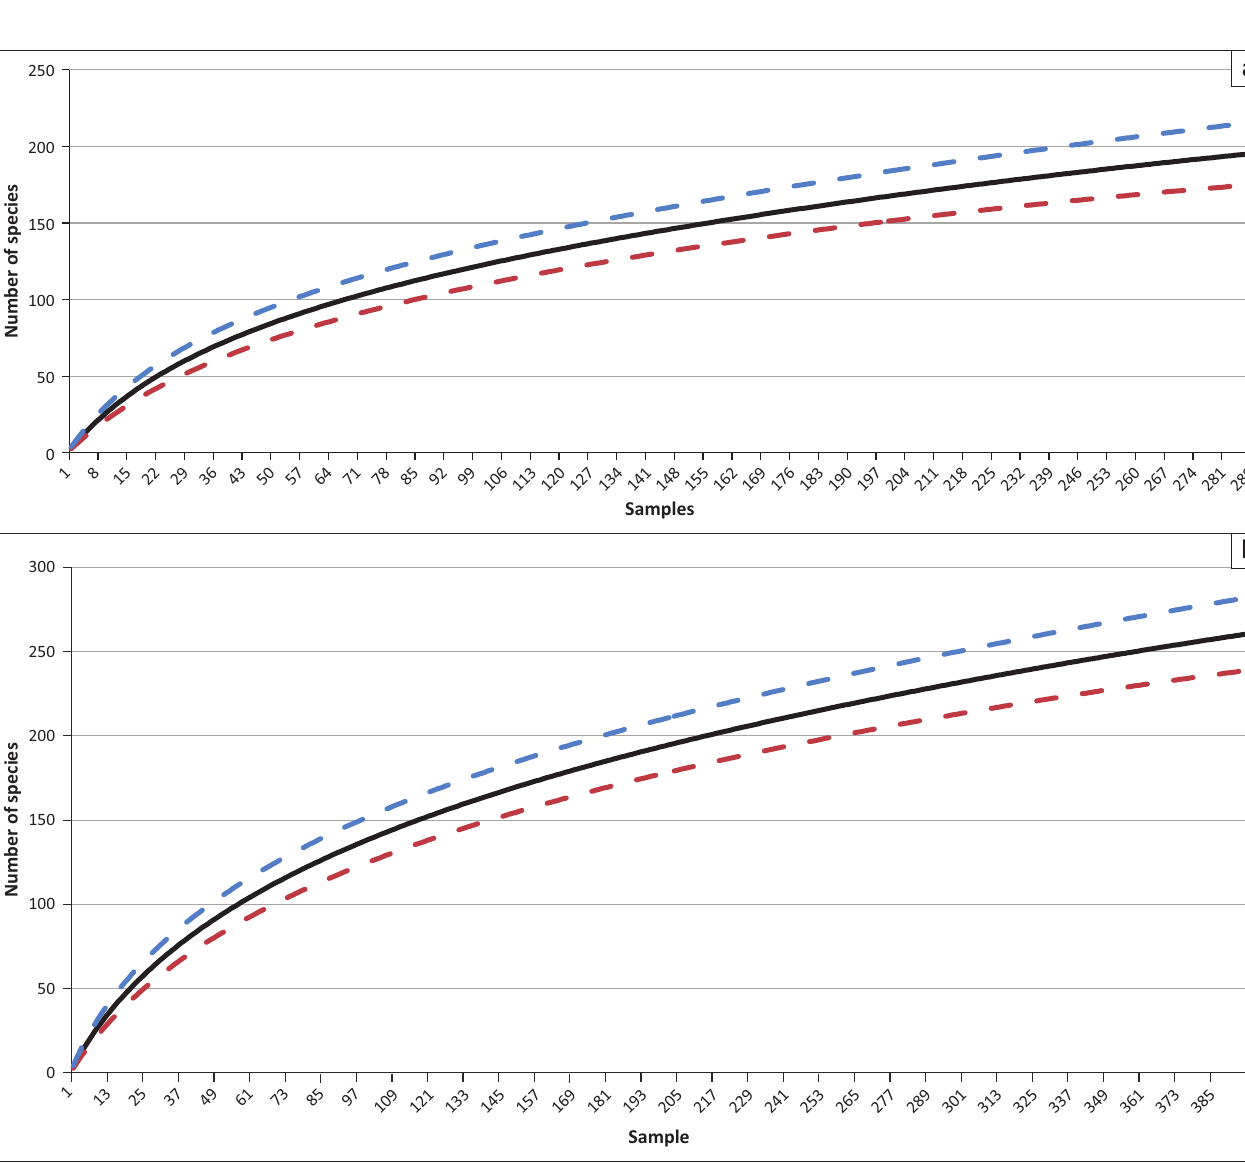
FIGURE 4: Species accumulation curves for (a) forest and (b) grassland sites at Mkambati Nature Reserve, calculated based on samples and using S(est), the expected number of species in pooled samples given the reference sample (189 = 163 species for forest, and 291 = 228 species for grassland), and showing the upper and lower 95 % confidence limits (dashed